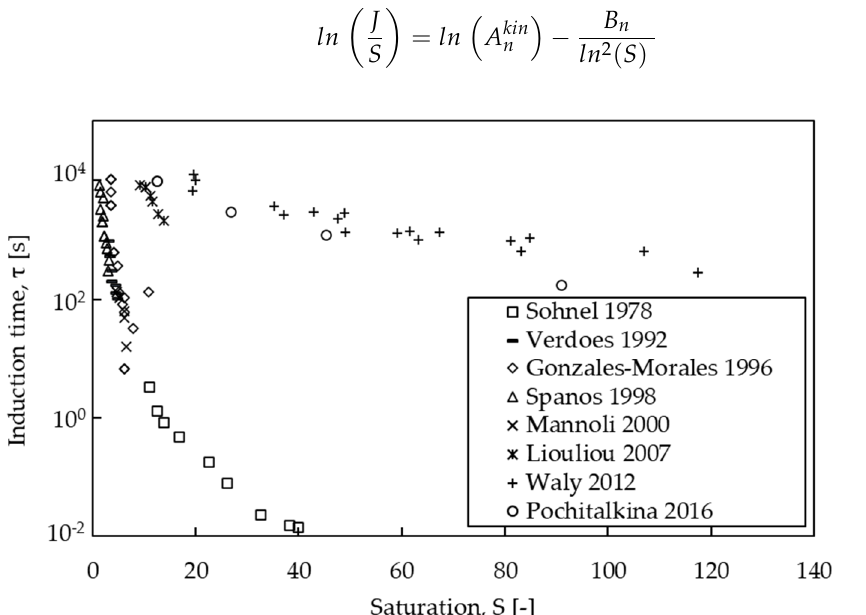
Table 3. Experimental details of studies on the nucleation of calcium